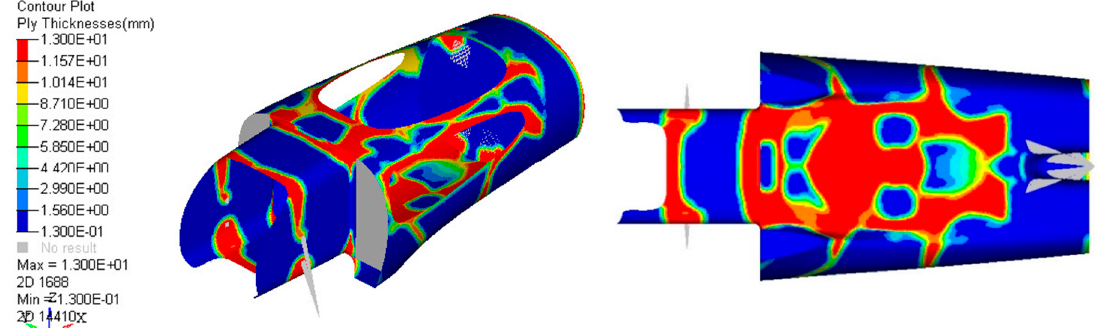
Figure 7. Exit displacements without ( left ) and with ( right ) windows.